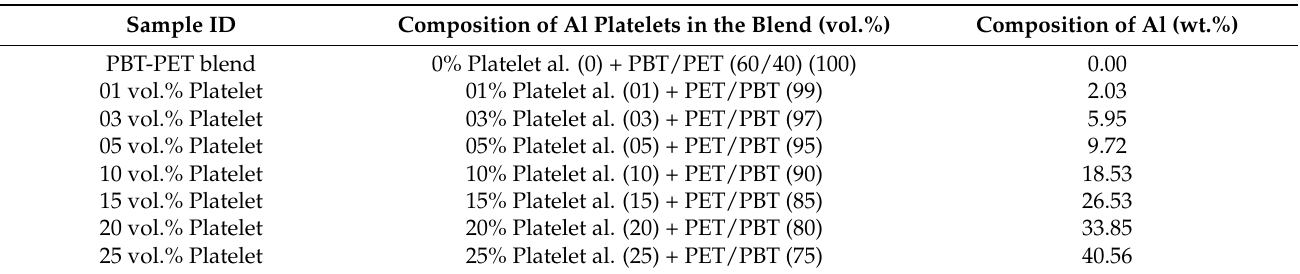
Figure 1. Schematic diagram of the composite preparation process. Table 1. Formulations of the Al nano platelet composites in a 60/40 PBT/PET matrix. The PBT/PET blend’s density was 1.3192 g/cm 3 while Al has a density of 2.70 g/cm 3 .